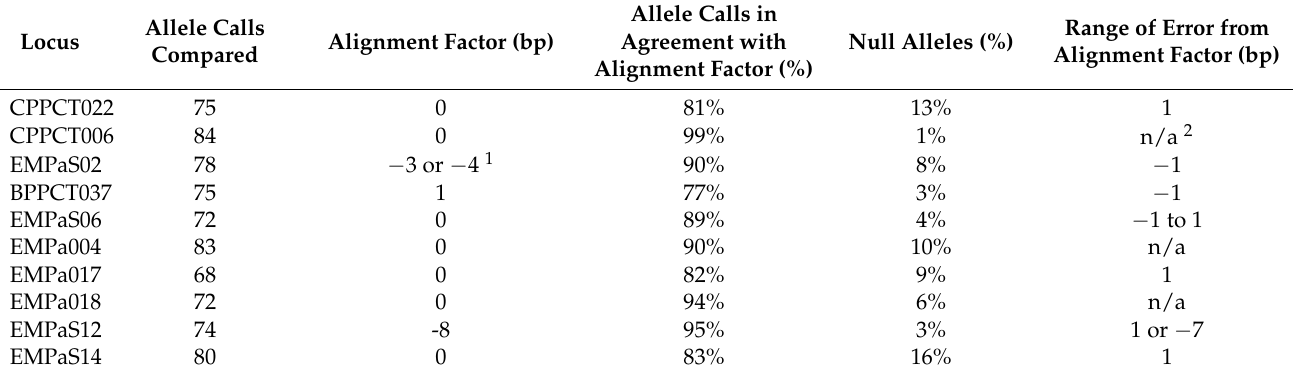
Table 1. Summary of allelic comparisons from alignment of two phases of GB national